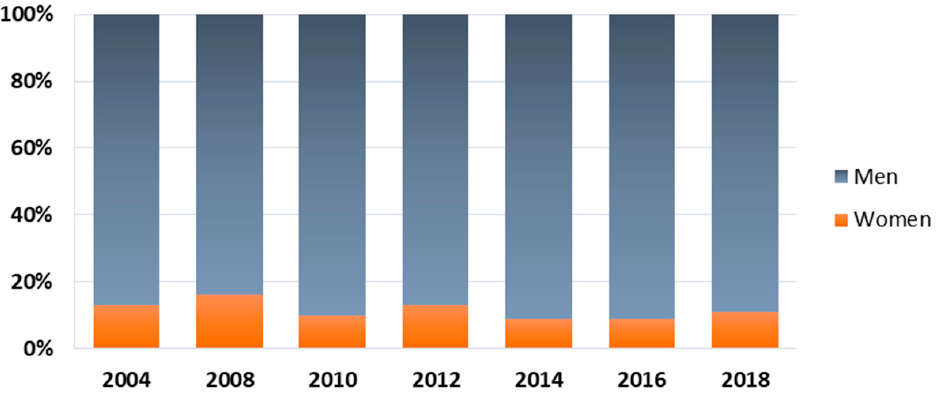
Figure 6. Mining and quarrying—employment with divisions into men and women, based on GUS, women, and men in the labor market (2004–2018). women, and men in the labor market